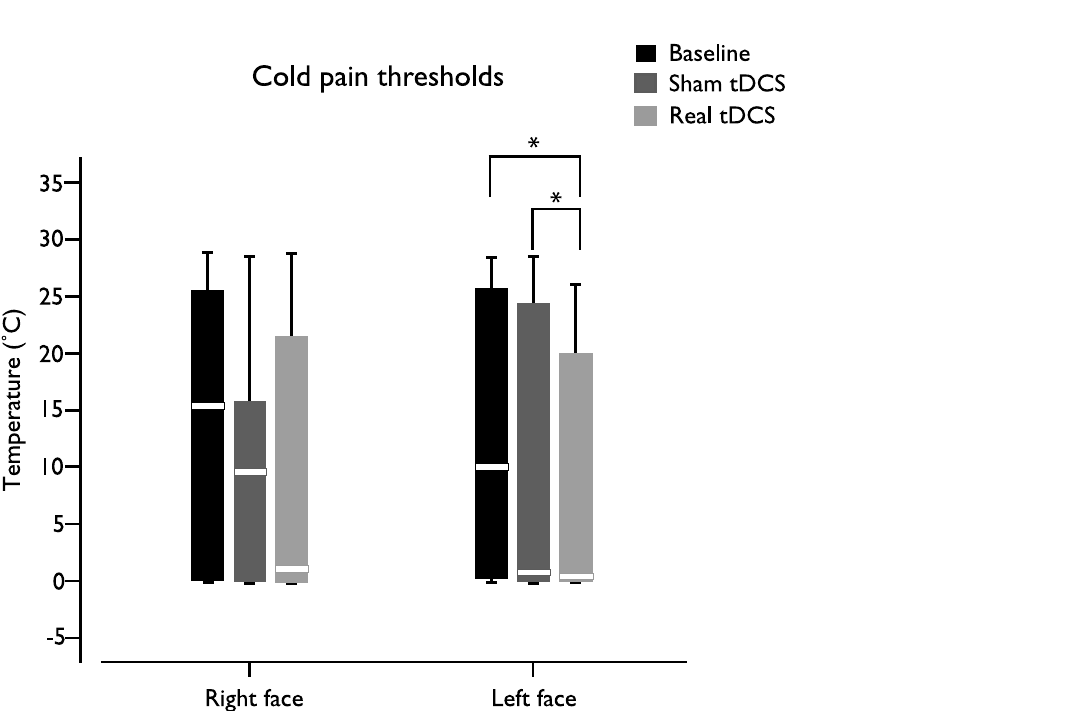
Figure 5. Box plot illustrating cold pain thresholds variations related to placebo and real tDCS. Statistically significant changes occurred in the cold pain thresholds of the left face ( p =0.012) throughout the experiment.